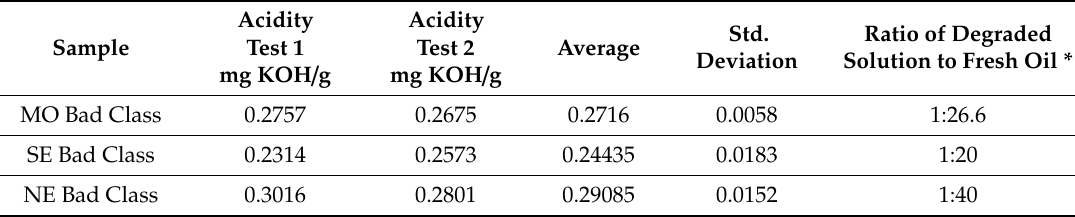
Table 2. Details of acidity measurements of bad class insulating liquids.